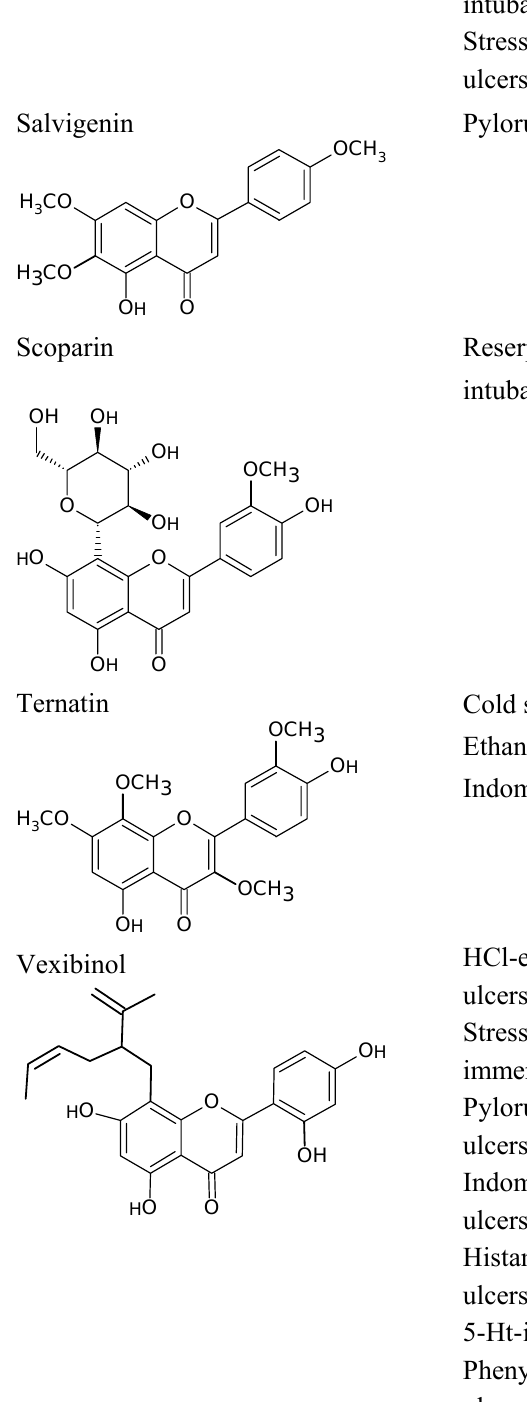
Table 1 . Cont. Reserpine-induced